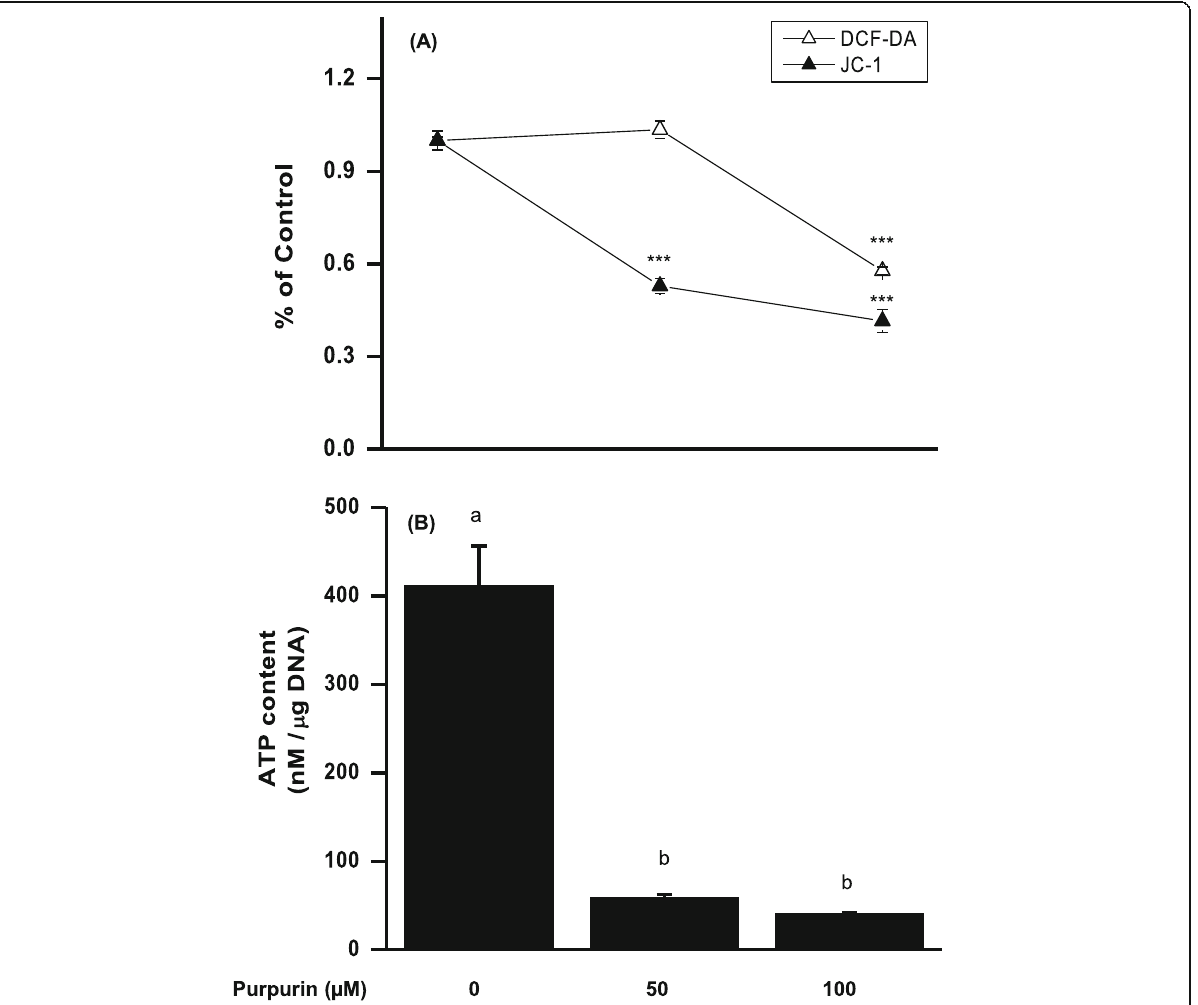
Fig. 4 Effects of purpurin on intracellular ROS levels, mitochondrial membrane potential, and intracellular ATP levels in 3T3-L1 cells treated with MDI for 48 h: a cells were labeled with DCF-DA for cellular ROS detection, and JC-1 for the detection of mitochondrial membrane potential; b cells were lysed, centrifuged and the supernatant mixed with luciferase/luciferin reagent, after which free ATP was detected with a luminometer. Data are expressed as the mean ± SD of triplicate experiments. Bars sharing a common letter are not significantly different at p <